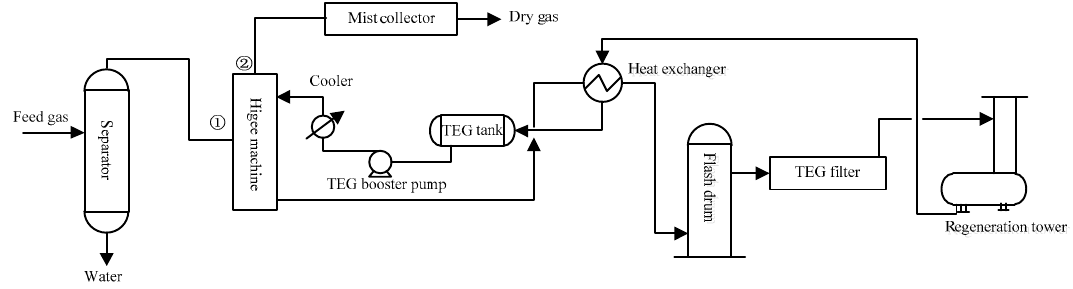
Figure 9. Flow chart of field experiment.